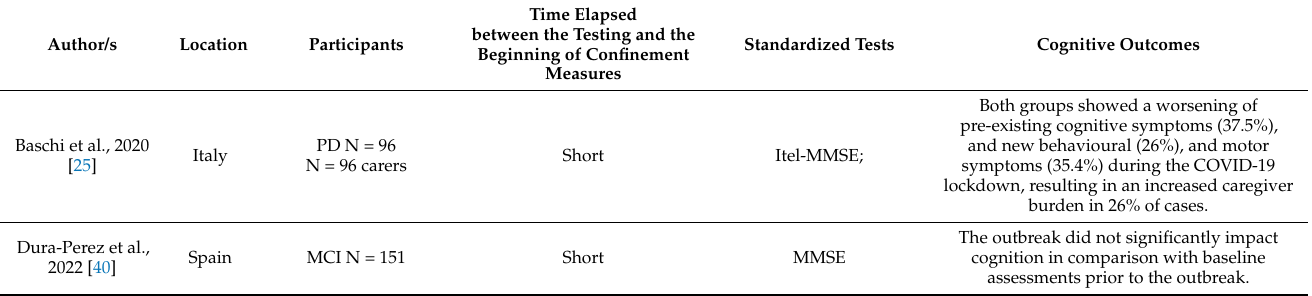
Table 1. Summary of studies reporting the negative effects of COVID-19 lockdown measures on cognitive performance, respectively, in people with neurological conditions and healthy people